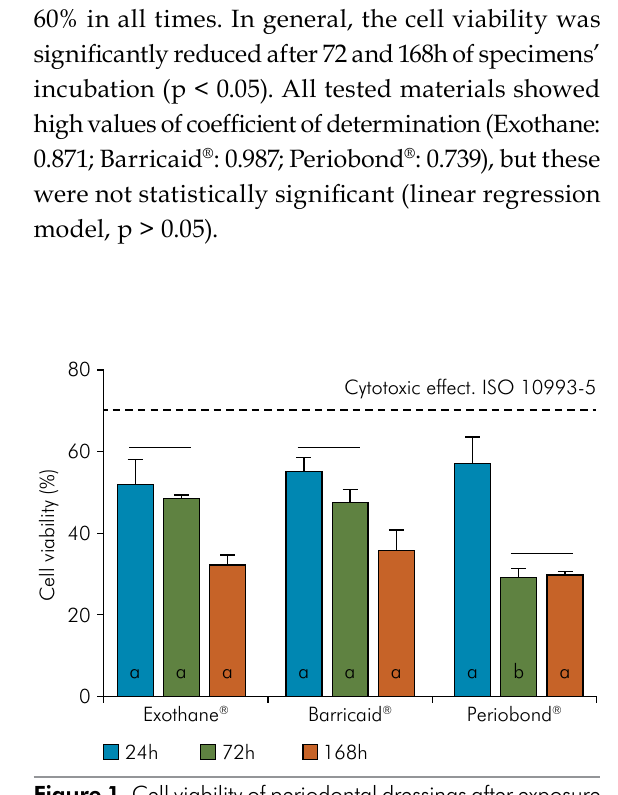
Figure 1. Cell viability of periodontal dressings after exposure to 24h, 72h, or 168 h eluates. Columns under the same horizontal line indicate no differences between specimen’s incubation period for each period material. Different lowercase letters indicate differences between materials within each specimen’s incubation